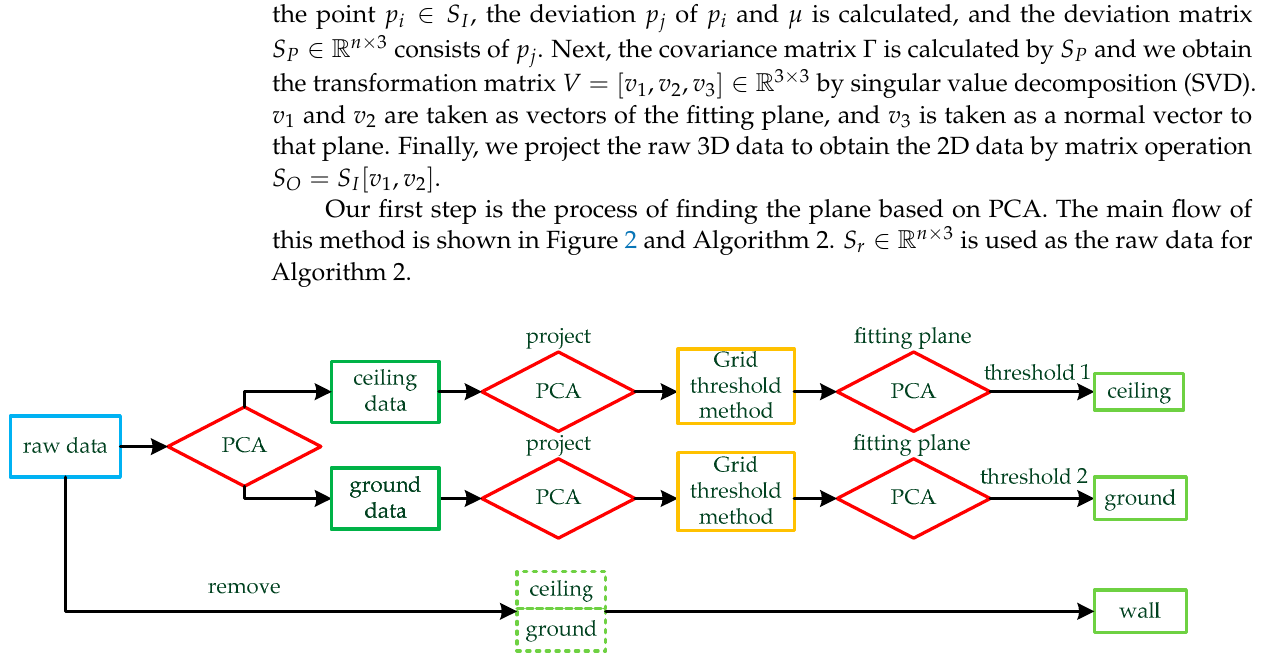
Figure 2. Wall extraction method based on PCA: PCA is used to fit the plane for the raw data, and the data are divided into two parts by the plane: ceiling data and ground data. The two parts of data are projected into two-dimensional data by PCA, and then the grid threshold method is used to find the feature points of the ground and ceiling. PCA is used to fit the feature points to obtain the level of the ground and ceiling. Finally, thresholds are set for the two planes and the point clouds of the floor and ceiling are removed.